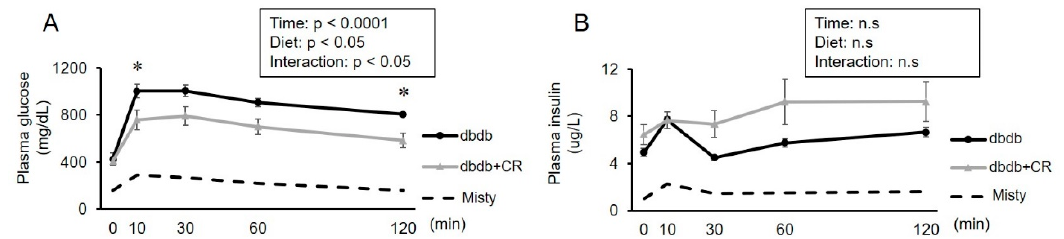
Figure 2. Effects of calorie restriction on glucose tolerance in db/db mice. Plasma glucose ( A ) and insulin ( B ) concentrations after oral glucose administration. dbdb, db/db ad libitum-fed control group; dbdb+CR, daily calorie restriction group. Data of misty mice were used as reference values (dotted lines). Data are the mean ± SEM ( n = 5). * p < 0.05 compared with the dbdb group.